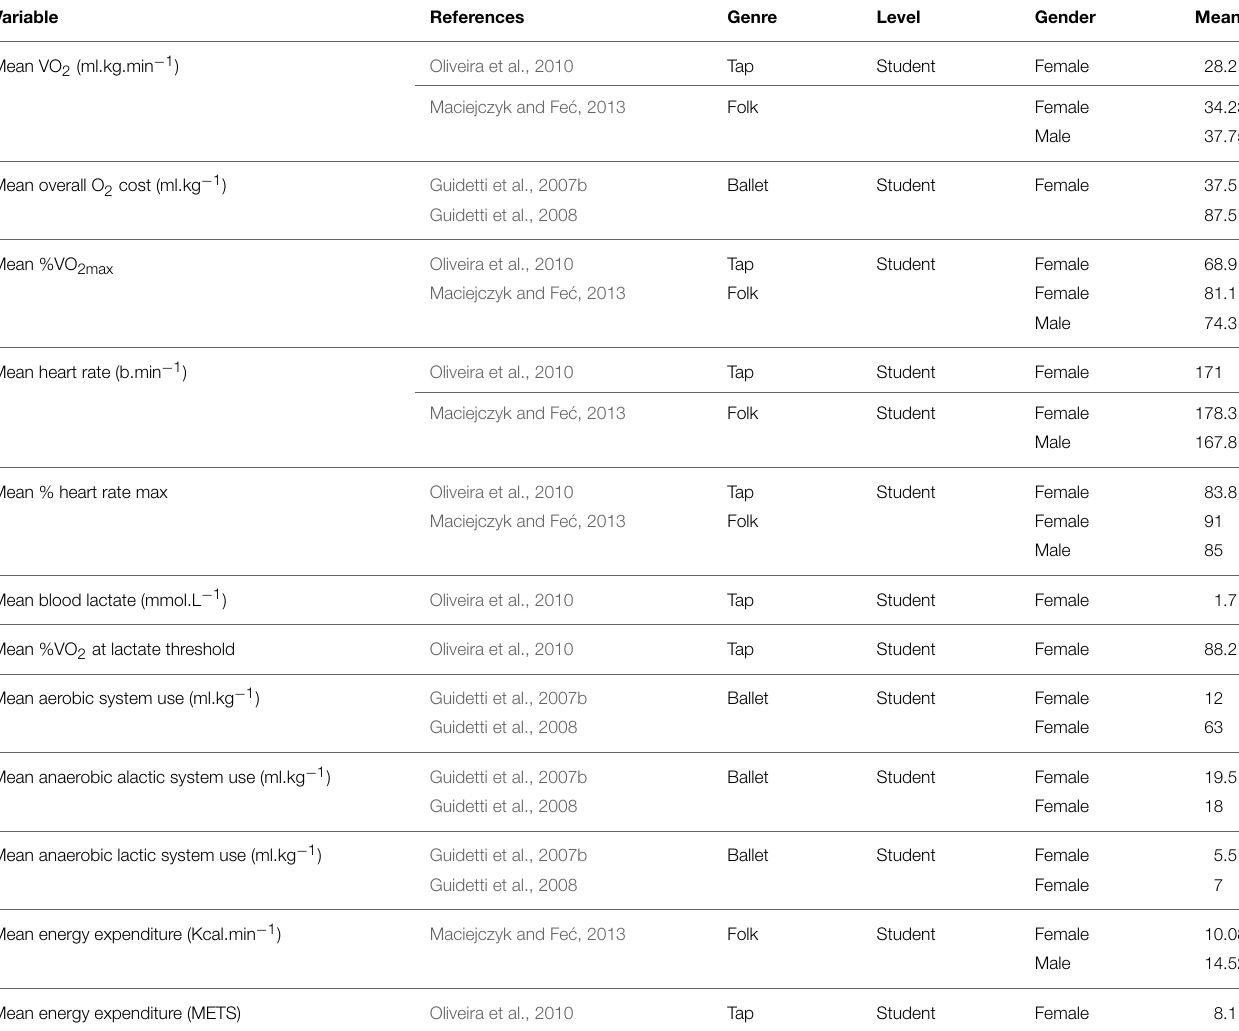
TABLE 2 | Mean data of studies examining the energy demand of a single exercise within dance class.